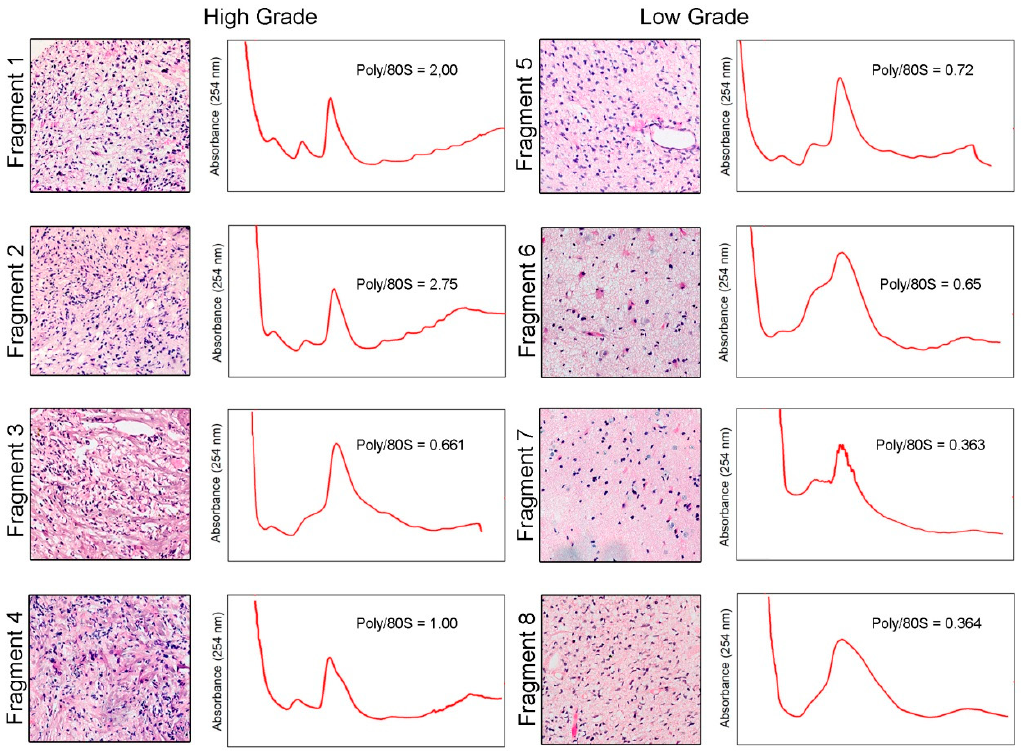
Figure 1. Distinct regions of a human glioblastoma (GBM) tumor present very different histological characteristics and translational rates (original magnification 10 × ). The tumor was dissected in eight different fragments based on macroscopical appearance of the tissue. Histological characteristics of each fragment were evaluated by HE staining and classified in high- (numbered 1 to 4) or low-grade (numbered 5 to 8). Fragments were lysed and polysome profiles were obtained by separation using ultracentrifugation in a 7–47% sucrose gradient. As a measure of translation levels, the areas under the polysome and 80S peaks were determined and the ratios of polysome/80S peak were calculated.